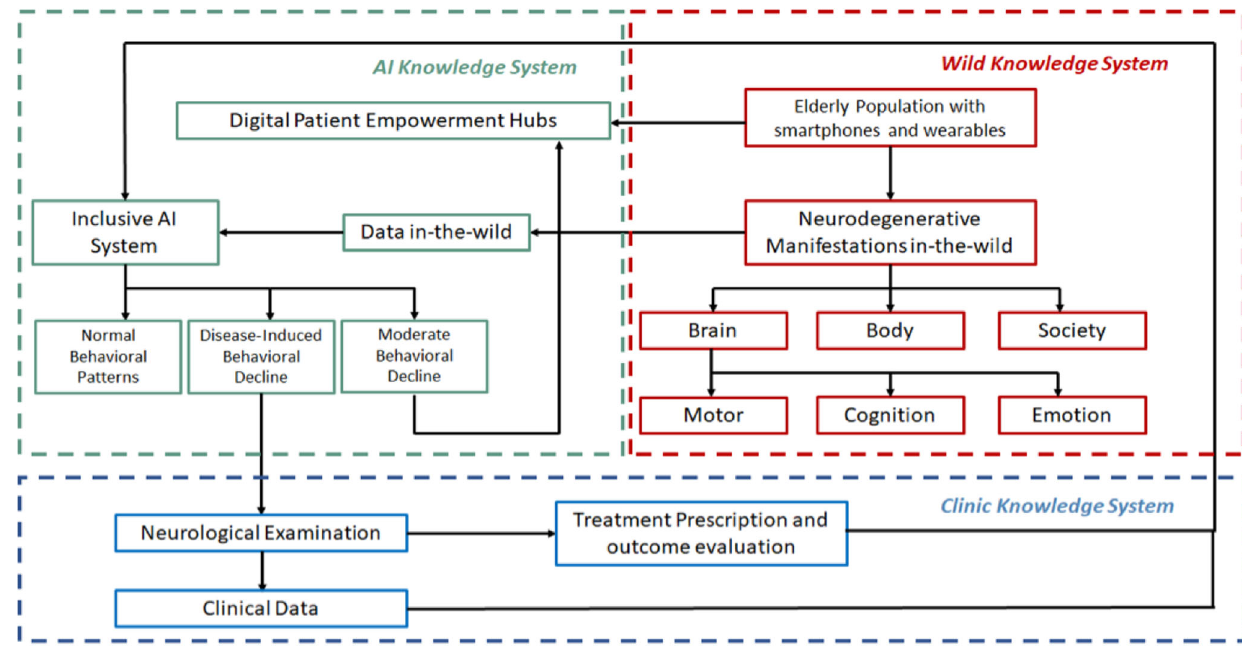
Fig. 5 The fl ow of knowledge in a multidisciplinary co-creation approach. The AI Knowledge System is centered on data acquired in-the- wild and digested by novel machine/deep learning algorithms to infer disease-induced behavioral decline. The Wild Knowledge System that includes elderly populations who interact with smartphones and wearables resulting in a rich space of behavioral data re fl ective of early neurodegeneration. The Clinic Knowledge System that involves medical decisions based on neurologists evaluation, generating clinically- validated multimodal datasets of early